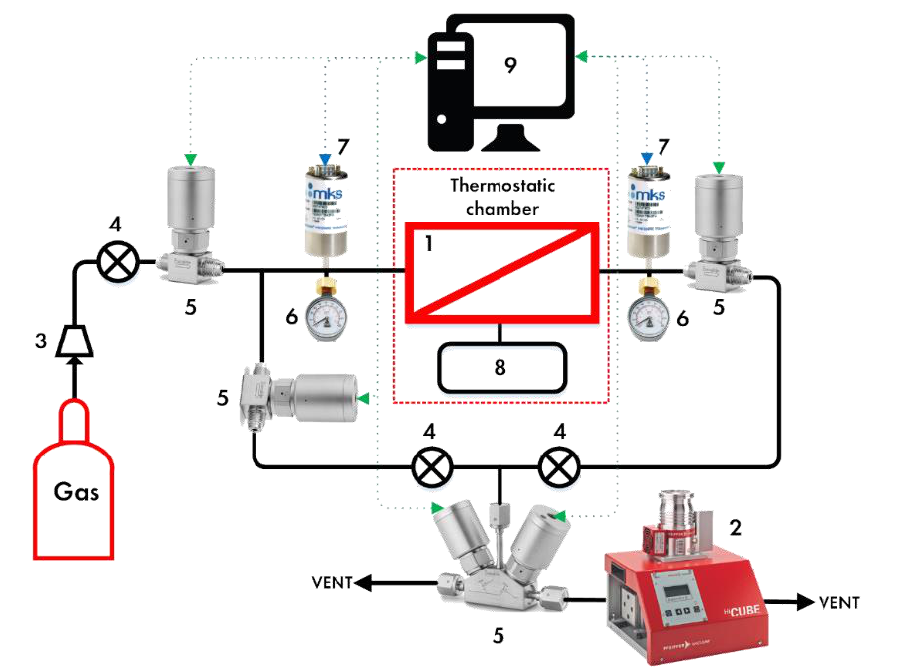
Figure 3. The principal scheme of time-lag setup. 1 — membrane test cell; 2 — vacuum station; 3 — manual pressure regulator; 4 — diaphragm manual valves; 5 — diaphragm valves with pneumatic actuators; 6 — pressure gauges; 7 — pressure transducers; 8 — additional volume; 9 — personal com-